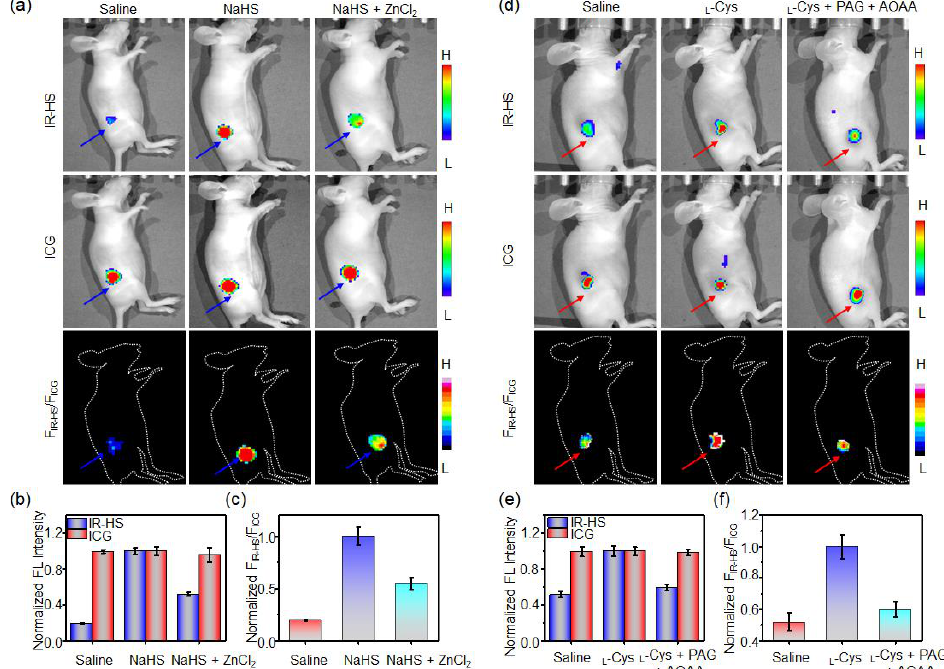
Figure 5. Non-invasive imaging of H 2 S in vivo. ( a ) Fluorescence and ratiometric images of mice following the subcutaneous injection of saline (25 µ L) plus HS-CG (20/20 µ M IR-HS/ICG, 25 µ L), HS-CG plus NaHS (1 mM, 25 µ L), and HS-CG plus ZnCl 2 (1 mM) + NaHS (1 mM, 25 µ L). ( b ) Fluorescence intensities of HS-CG and ( c ) the fluorescence intensity ratio (F IR-HS /F ICG ) following treatment with HS-CG, HS-CG plus NaHS, and HS-CG plus NaHS plus ZnCl 2 . ( d ) Fluorescence and ratiometric images of HCT116 tumors in mice at 12 h following intravenous (i.v.) injection of HS-CG (40/40 µ M IR-HS/ICG, 200 µ L), HS-CG plus L -Cys (1 mM, 25 µ L), and HS-CG plus L -Cys plus PAG (5 mg/kg) +AOAA (5 mg/kg). ( e ) Fluorescence intensities of HS-CG and ( f ) the fluorescence intensity ratio (F IR-HS /F ICG ) following treatment with the indicated treatment. Values are mean ± s.d. ( n = 3). When HS-CG was intravenous (i.v.) injected into s.c. HCT116 tumor-bearing mice,